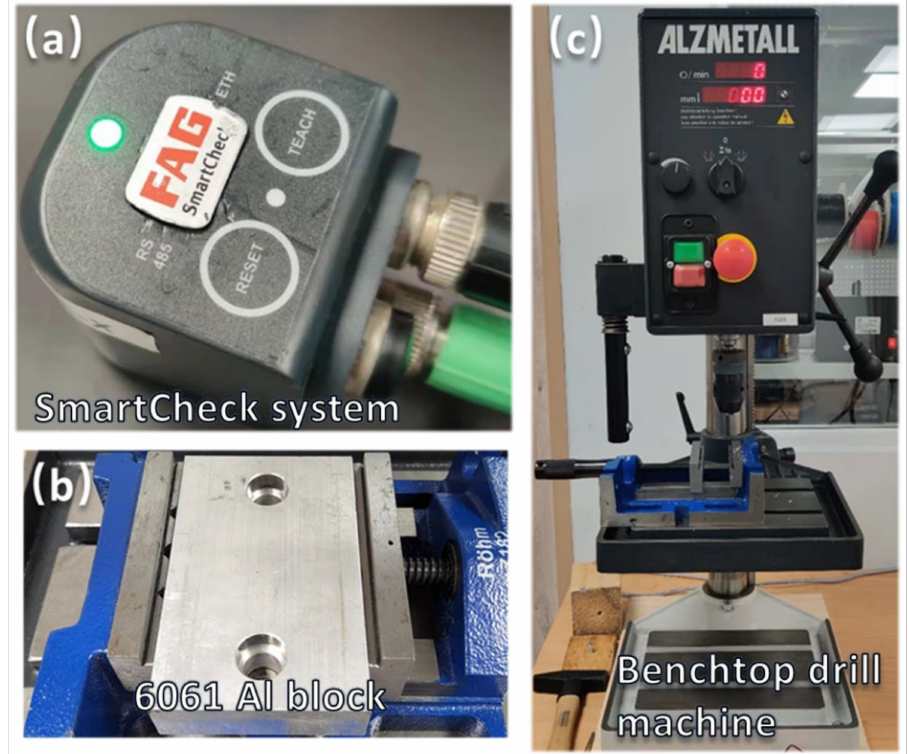
Figure 2. ( a ) An image of the SmartCheck system, ( b ) an image of the aluminum block, and ( c ) an image of the drill machine used in the